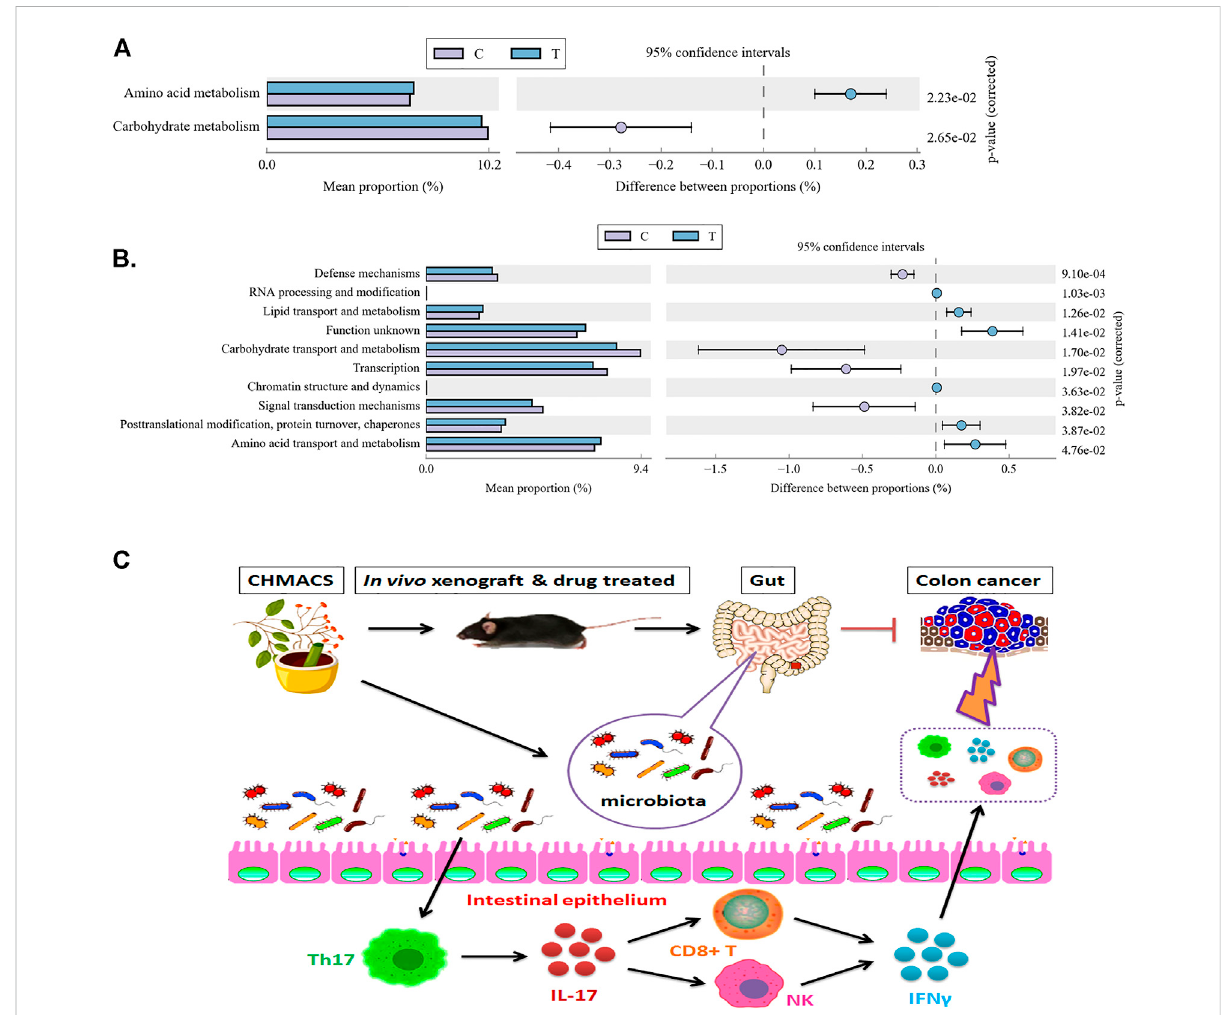
FIGURE 9 Metabolic signaling pathways and protein differences in gut microbiota. (A) Kyoto Encyclopedia of Genes and Genomes metabolic pathway analysis. (B) Analysis of clusters of orthologous groups of proteins to evaluate distribution and abundance of homologous protein clusters in gut microbiota. (C) CHMACS activates immune cells, which kill CC cells, by regulating the gut microbiota – Th17